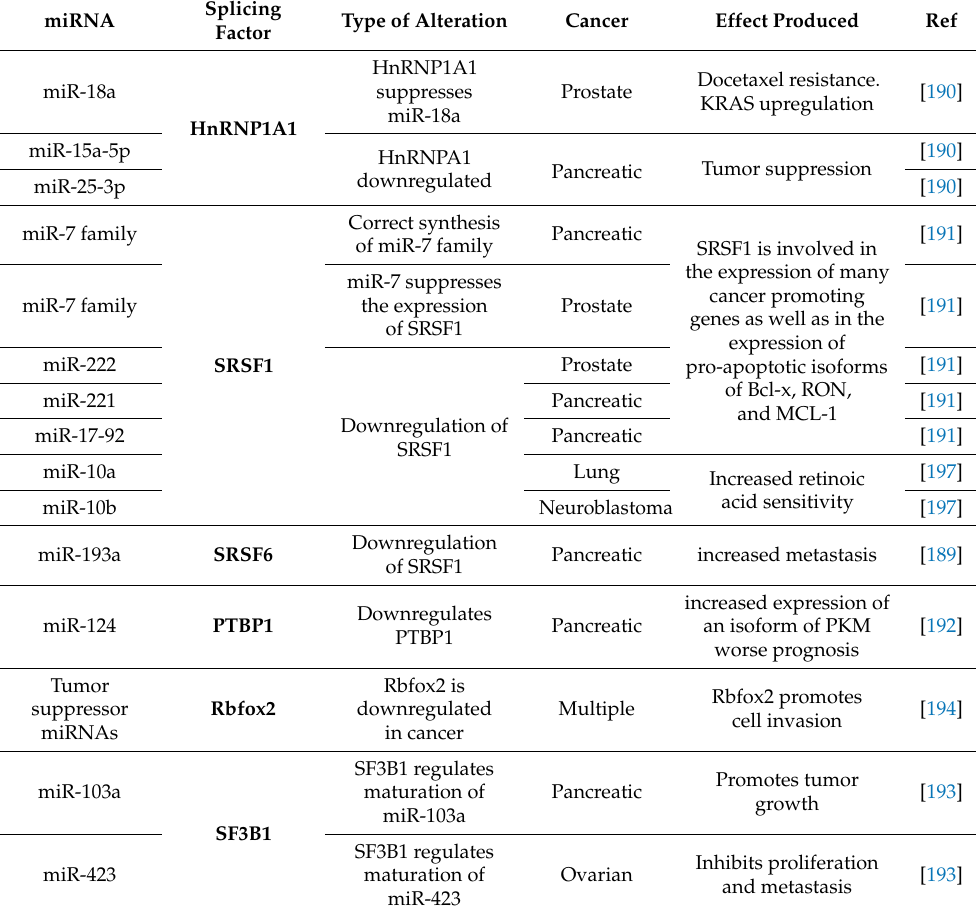
Table 7. The interaction between miRNAs and splicing factors in drug resistance. Splicing Type of Alteration Cancer Effect miRNA Factor